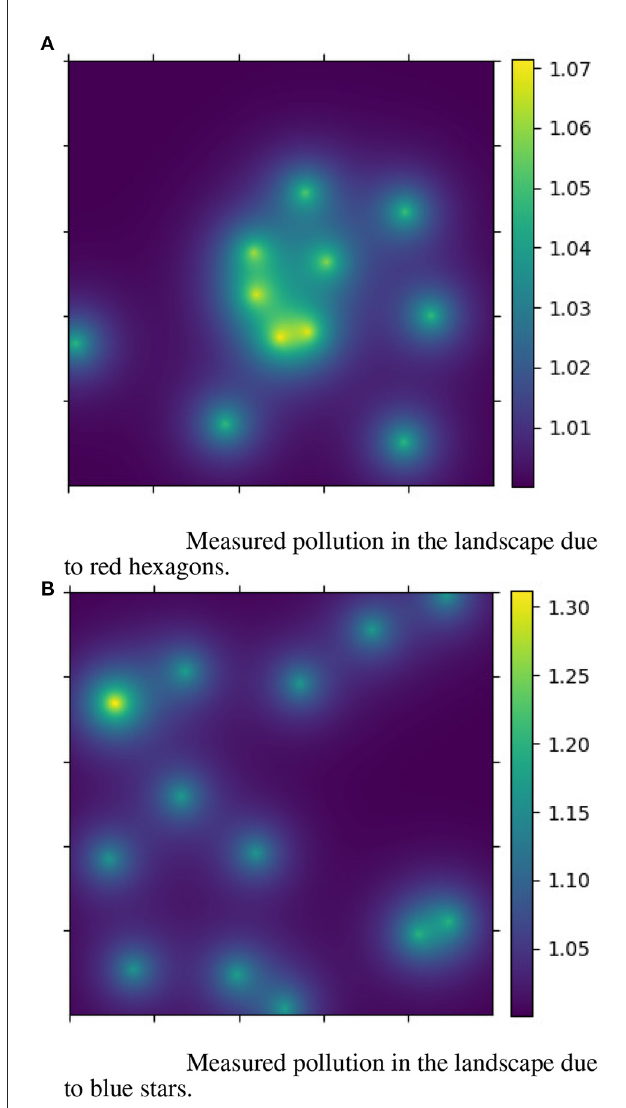
FIGURE2 A similar random layout of farms as Figure 1 but where some farms are connected, e.g., by a road or river, that provides a mechanism for greater interaction with their neighbors. We model the interaction as a halving of the distance between connected farms. We can see that the shielding effects from neighboring farms is diminished leading to lower profit for farm 20, and that the presence of a connection decreases the profit for both farm 0 and 5 but the later’s decrease is compensated by the neighboring similar farms. (A) Random layout of connected farms. (B) Profit for each farm (arbitrary units).